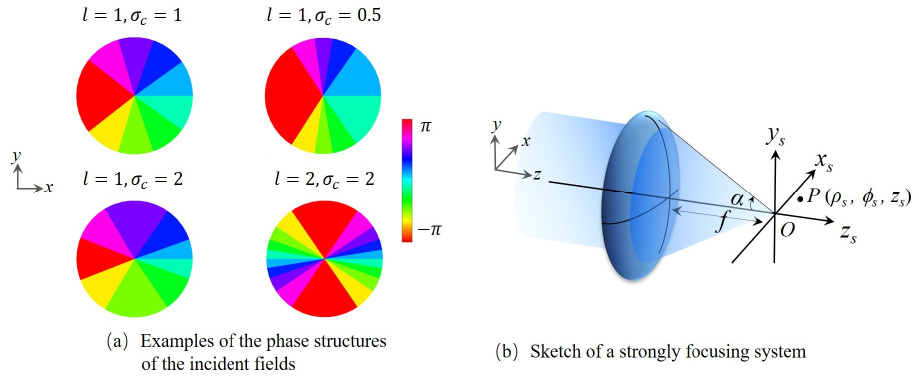
Figure 1. A strongly focusing system with an X-type vortex beam as the incident